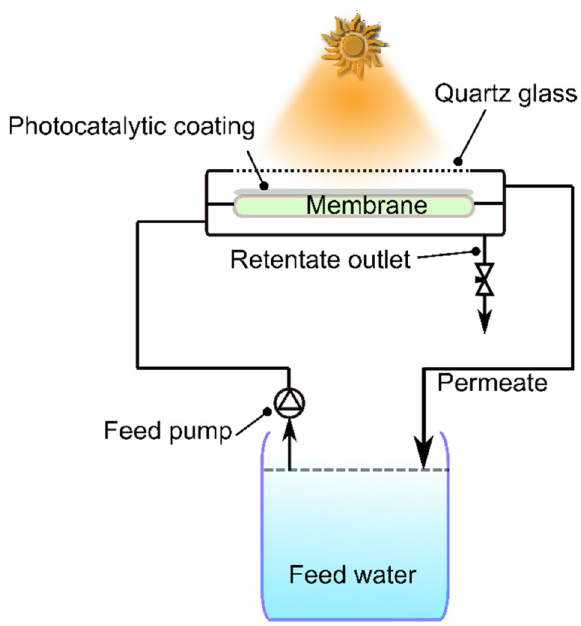
Fig. 4 Photocatalytic membrane reactors. An illustration of lab- scale PMR system operating via recirculating batch mode (inspired from 309